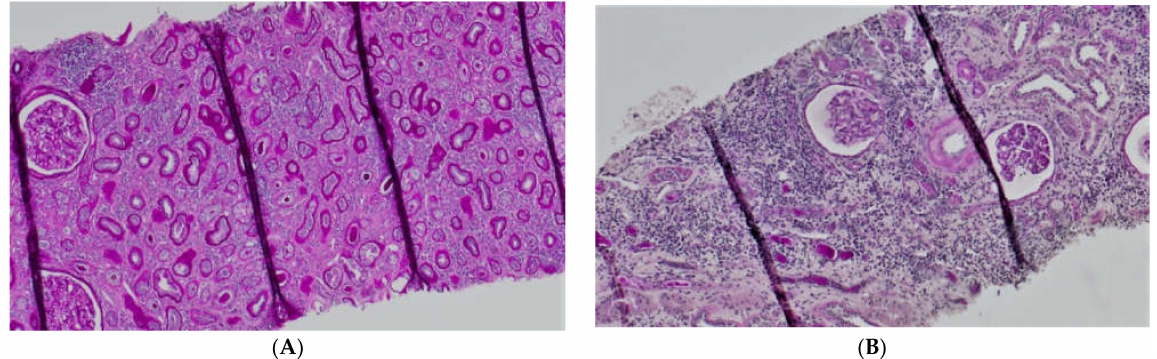
Figure 6. Histopathological images showing chronic changes graded as ci3, ct3 ( A , B ).